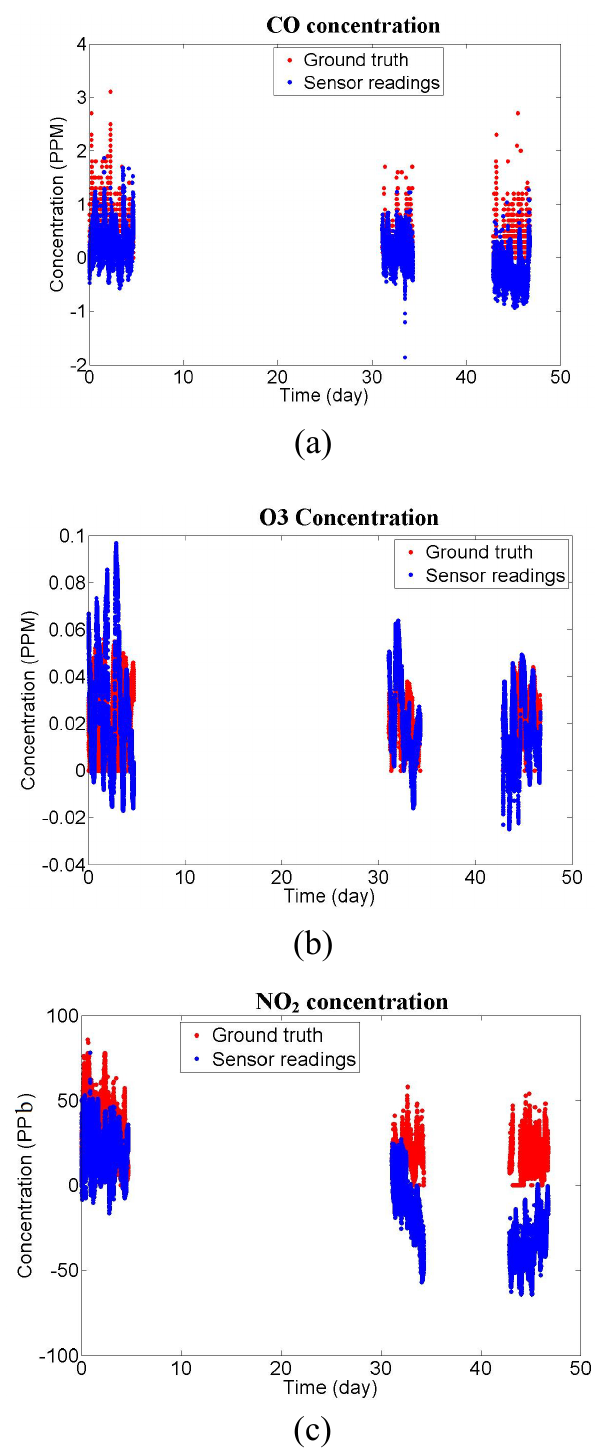
Figure 7. (a) Drift measurement of CO; (b) drift measurement of O 3 ; (c) drift measurement of NO 2